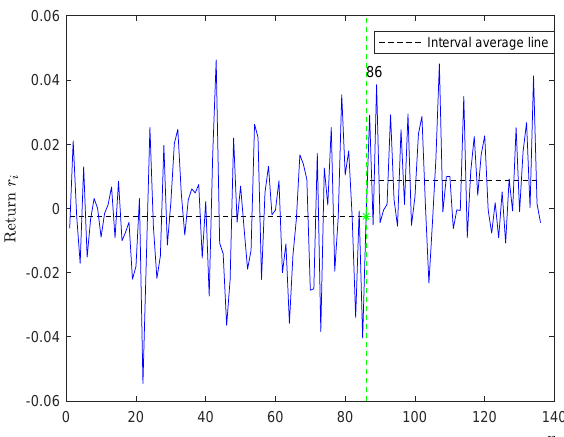
Figure 4. The plot graph of the mean returns of Tesla stock from 2016 to